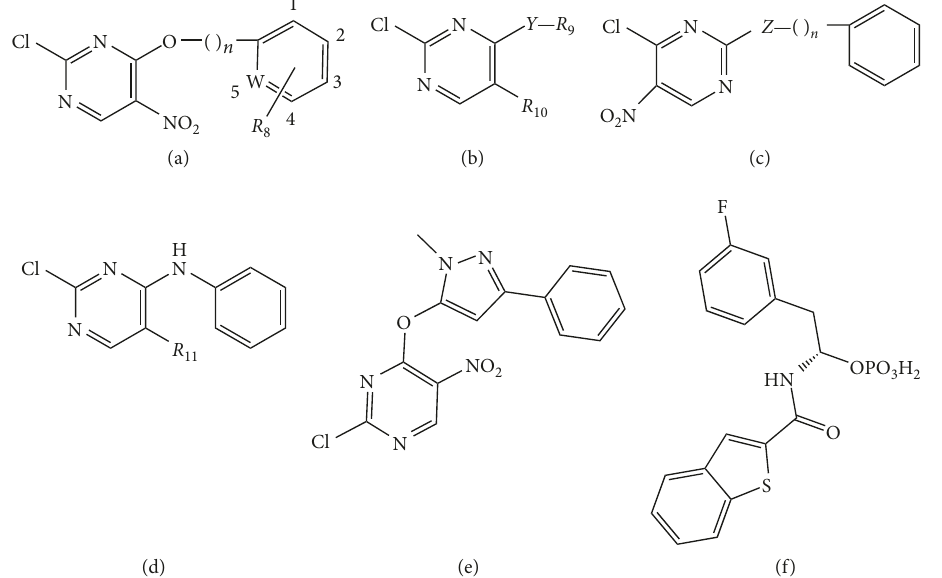
Scheme 3: Pyrimidine derivatives as potent Pin1 inhibitor core structure (a) for molecules 27–37, (b) for molecules 38–43, (c) for molecules 44–46, (d) for molecules 47 and 48, (e) Molecule 49, and (f) Molecule